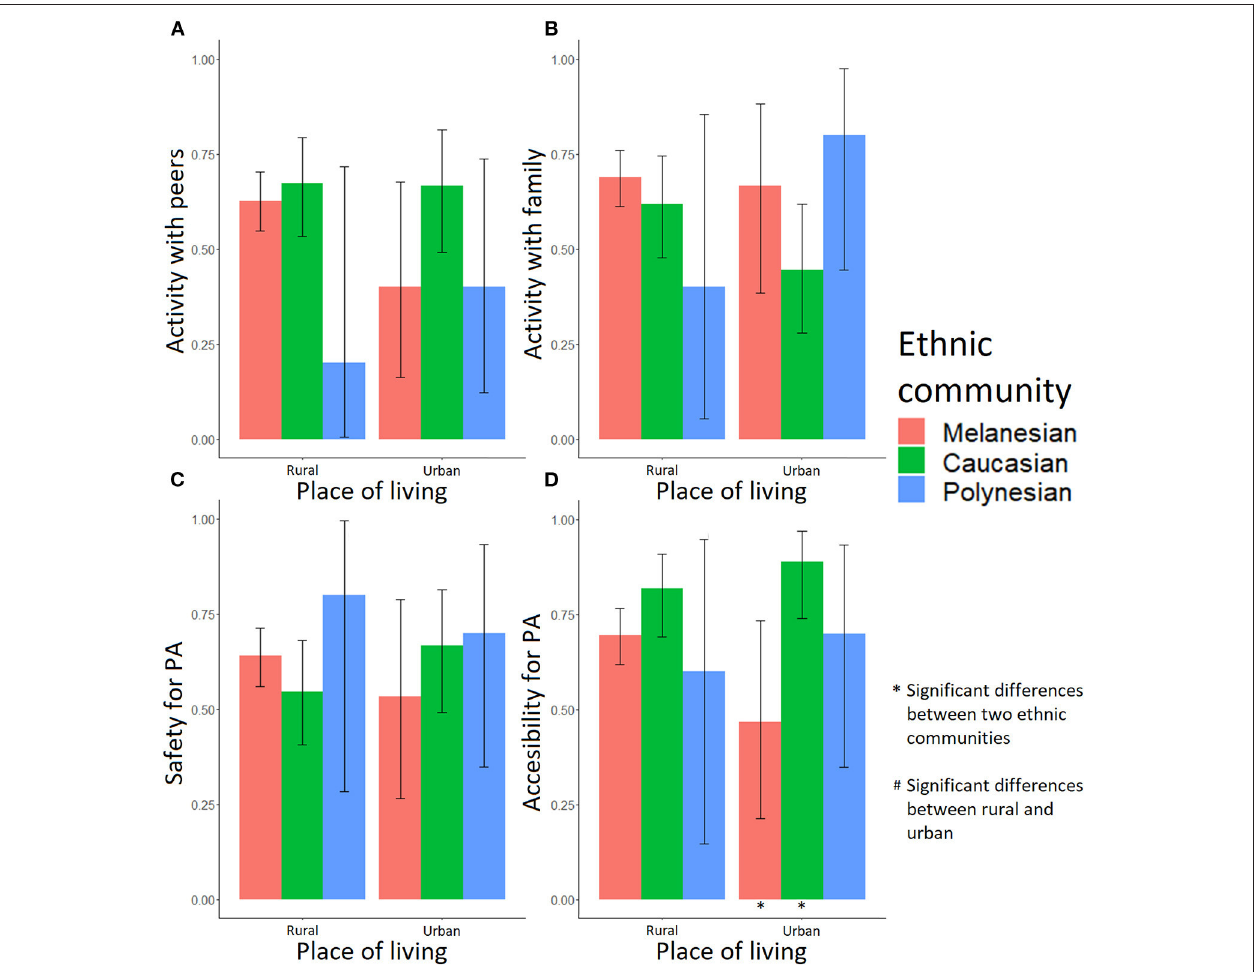
FIGURE 3 | Fractions of female adolescents for whom the socioenvironmental factors are important in PA practice. Activity: (A) with peers, (B) with family, (C) in safety, and (D) easy access. A “*” note means a significant difference between two ethnic communities in a single place of living; a “#” note means a significant difference between rural and urban environment in a single ethnic